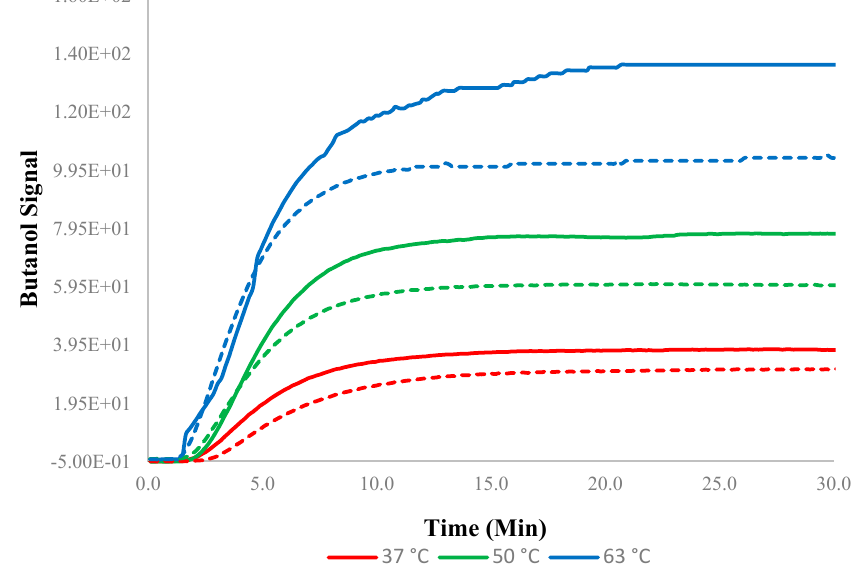
Figure 11. Transients for 0–1.5 w/w% at different temperatures. Solid lines indicate experimental data devised from the experiments using the PTMSP membrane blended with SNPs and dotted lines without SNPs (neat membrane). Data for pure PTMSP were taken from the literature [26].